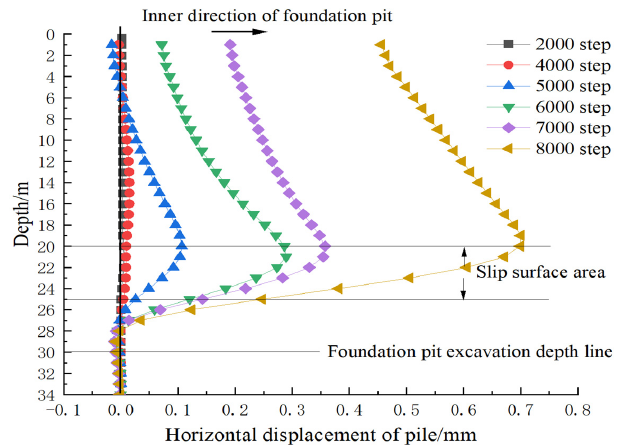
Figure 6. Displacement curve of cantilever piles with different pile diameters at 1.5 times pile spac- ing (three piles). (three